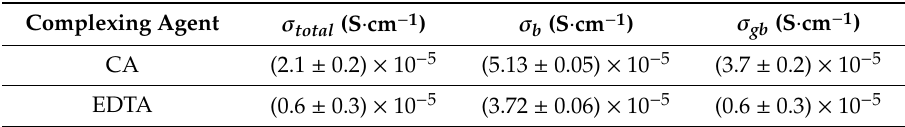
Table 2. Extracted conductivity values from EIS measurements for EDTA- and CA-assisted synthesized disks. The standard deviations of three independent measurements are presented in parentheses.